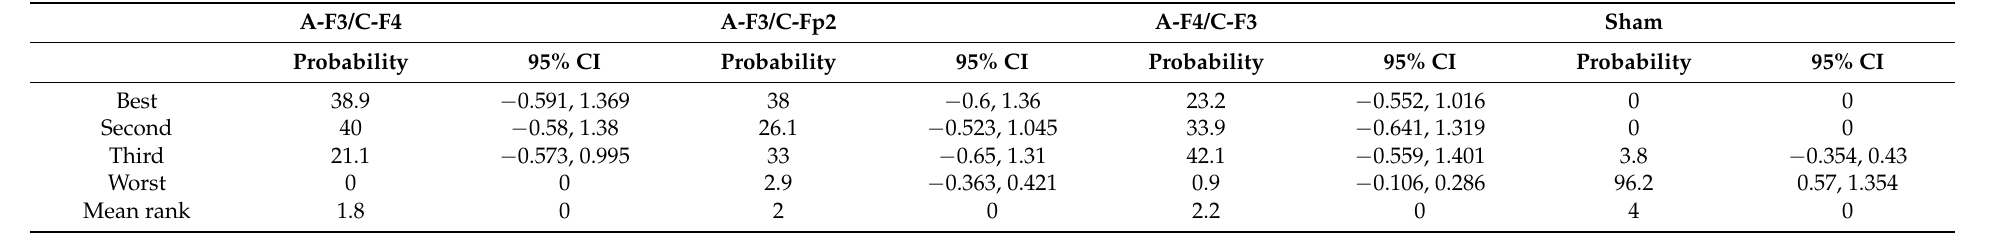
Table 2. Results: network meta-analysis electrode montage.